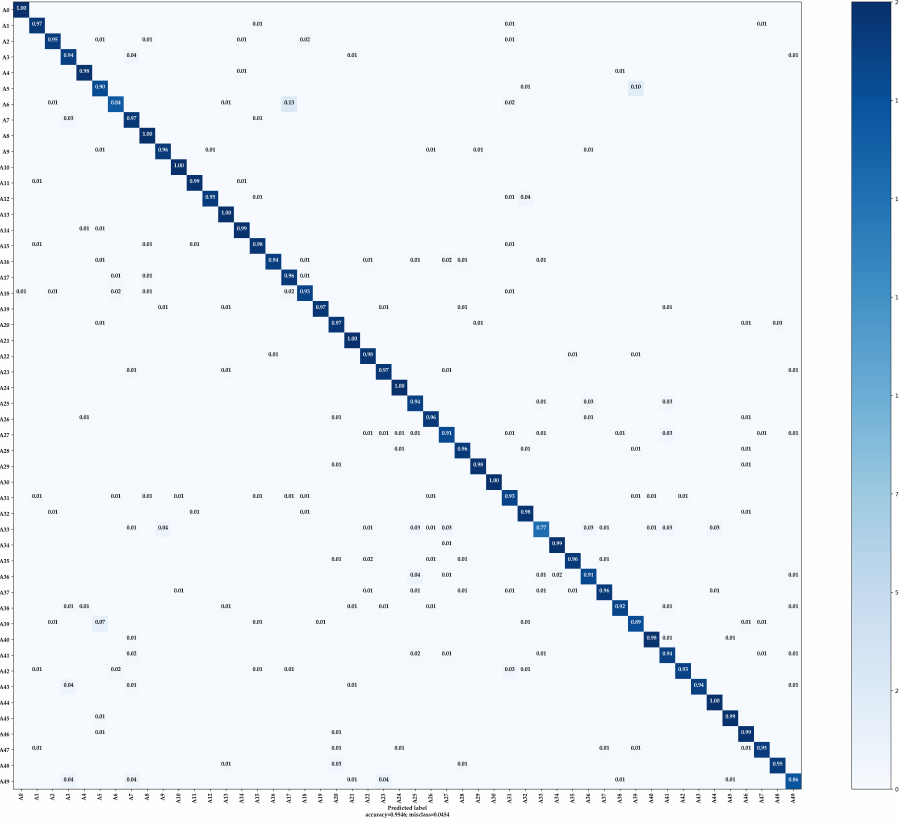
Figure 13. Confusion matrix of our P 2 FEViT (ViT-S/EfficientB3) on BIT-AFGR50 (train:test =